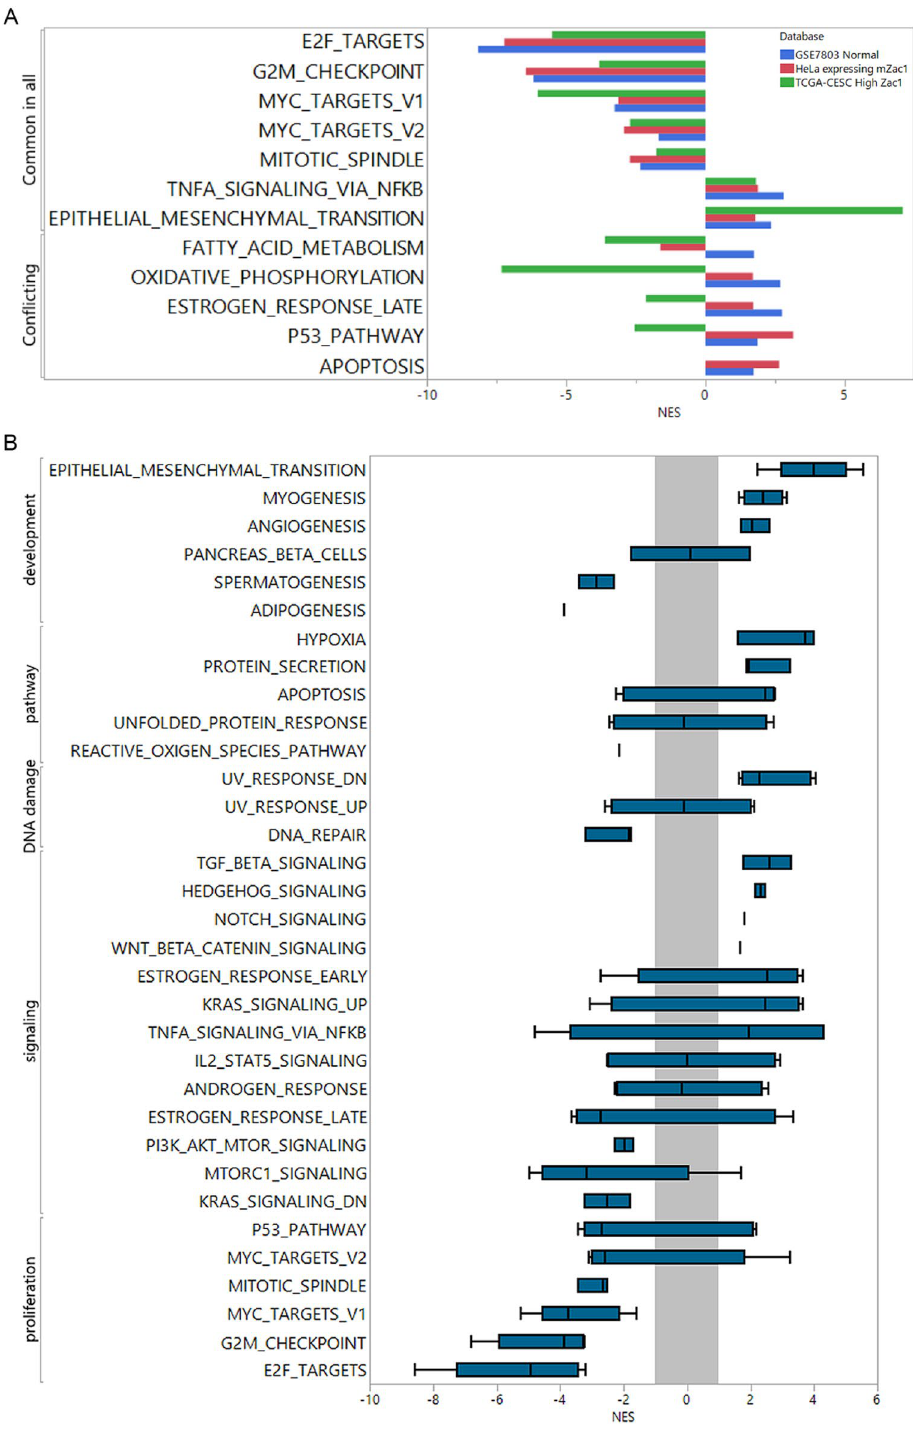
Figure 3. Enriched Hallmark gene-sets correlated to high Zac1 expression among comparisons within different databases. (A) NES of hallmark gene-sets were extracted respectively from GSEA comparing normal versus tumor cervical tissues (blue), HeLa cell with mZac1 overexpression versus control vectors (Red), and TCGA- CESC tumor samples with top 30% high Zac1 expression versus bottom 30% Zac1 low (Green). Negative NES represent the negative enrichment of gene-sets to high Zac1 expression. Common in all: NES of hallmark gene-sets were significantly ( P-value < 0.01, FDR < 0.2) and consistently prone to same trends. Conflicting: NES of Hallmark gene-sets were significantly enriched (FDR < 0.2) but have different trends. (B) NES were extracted respectively from the results of GSEA comparing top 30% high Zac1 expression versus bottom 30% Zac1 low within 5 cervical cancer databases accessible in NCBI GEO (accession ID: GSE9750, GSE44001, GSE52904, GSE63514 and GSE68339). Gray zone: − 1 < NES < 1, box plots of Hallmark gene-sets crossing gray zone were considered to have no specific correlation with Zac1